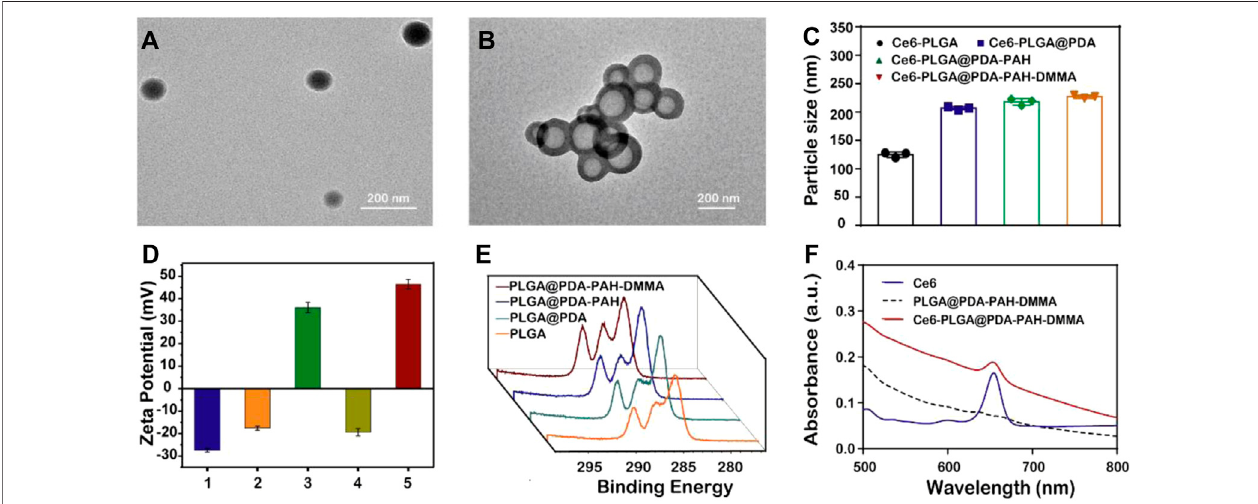
FIGURE 2 | Characterization of the synthesized NPs. TEM images of (A) Ce6-PLGA NPs; (B) Ce6-PLGA@PDA-PAH-DMMA NPs. (C) Particle size of synthesized NPs. (D) SurfacezetapotentialsofdifferentNPs(1,2,3,4,and5presentCe6-PLGANPs,Ce6-PLGA@PDANPs,Ce6-PLGA@PDA-PAHNPs,Ce6-PLGA@PDA-PAH- DMMANPs-pH7.4,andCe6-PLGA@PDA-PAH-DMMANPs-pH5.5). (E) XPSspectraofPLGANPs,PLGA@PDANPs,PLGA@PDA-PAHNPs,andPLGA@PDA-PAH- DMMA NPs. (F) UV-vis spectra of Ce6, PLGA@PDA-PAH-DMMA NPs, and Ce6-PLGA@PDA-PAH-DMMA